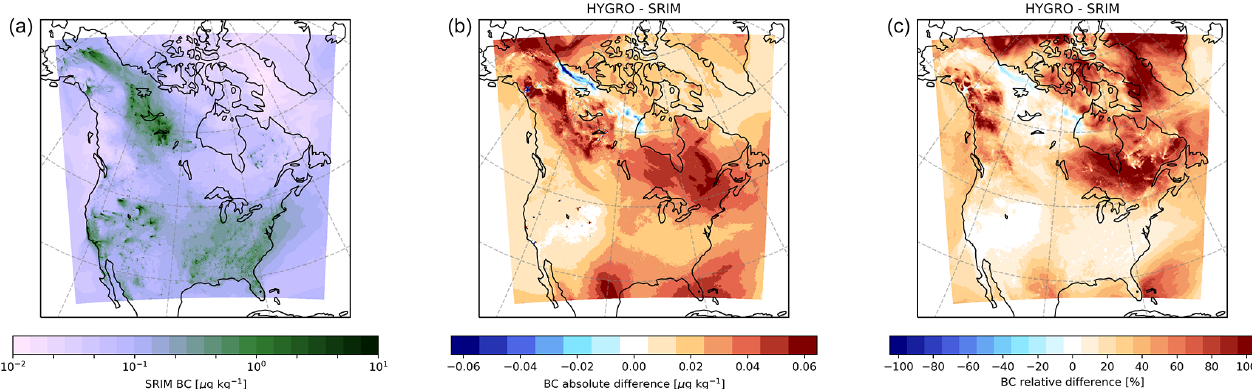
Figure 4. (a) Mean surface BC mixing ratios from the SRIM simulation, (b) mean difference in BC mixing ratios between the HYGRO and SRIM simulations, and (c) relative difference in mean BC mixing ratios between the HYGRO and SRIM